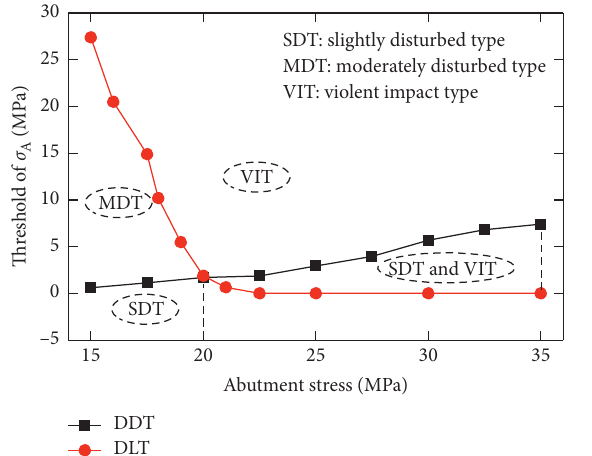
Figure 8: Results of the disturbing dynamic threshold and the large deformation caused dynamic threshold.